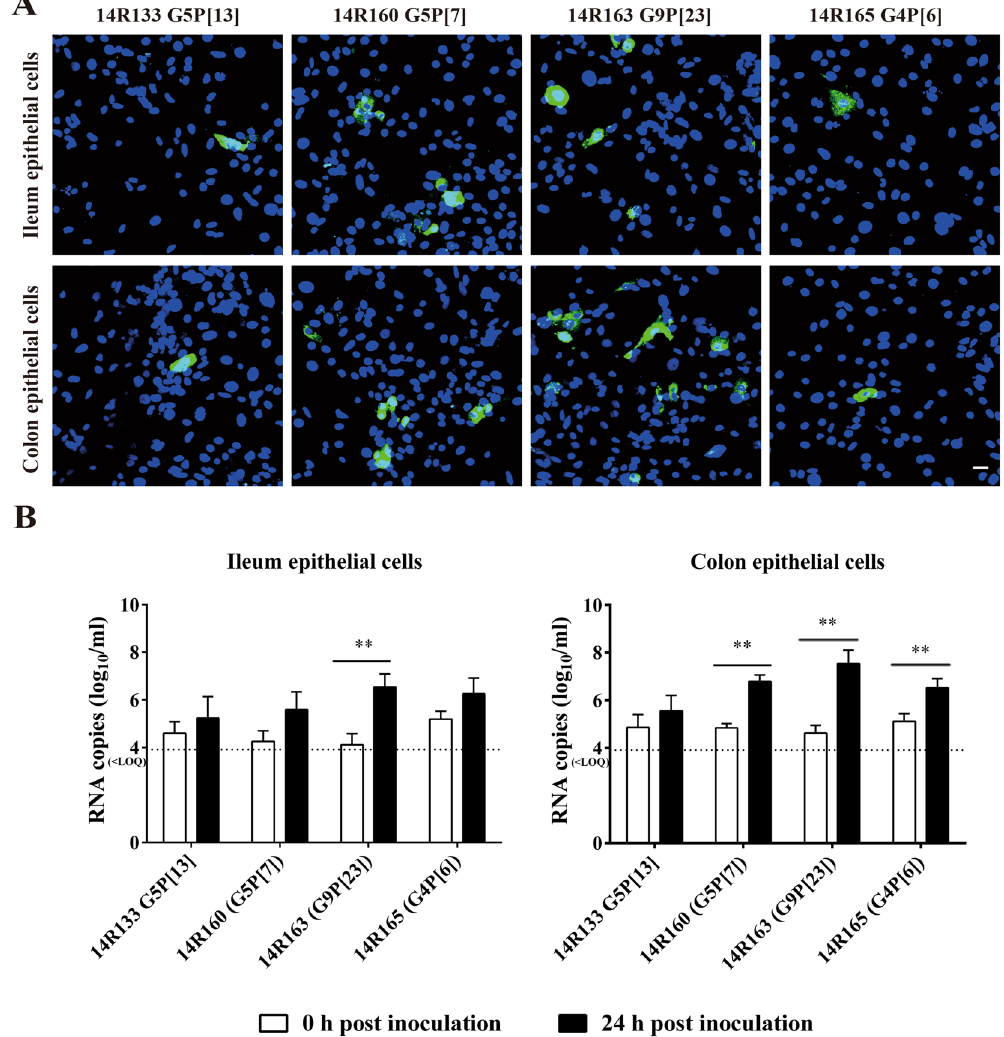
Figure 7. Susceptibility of porcine primary enterocytes to different rotavirus genotypes present in fecal suspension of diarrheic pigs. The infected cells were visualized by immunofluorescence staining at 24 h post inoculation ( A ). Viral RNA titer with supernatant of co-cultured primary porcine enterocytes inoculated with different rotavirus fecal suspensions at 0 h and 24 h post inoculation ( B ). Scale bar: 25 µ m. Data are expressed as mean ± standard deviation of the results of 3 separate experiments. Statistically significant differences in comparison with the data from 0 h p.i. are represented as * P < 0.05 or ** P < 0.01. < LOQ: below limit of